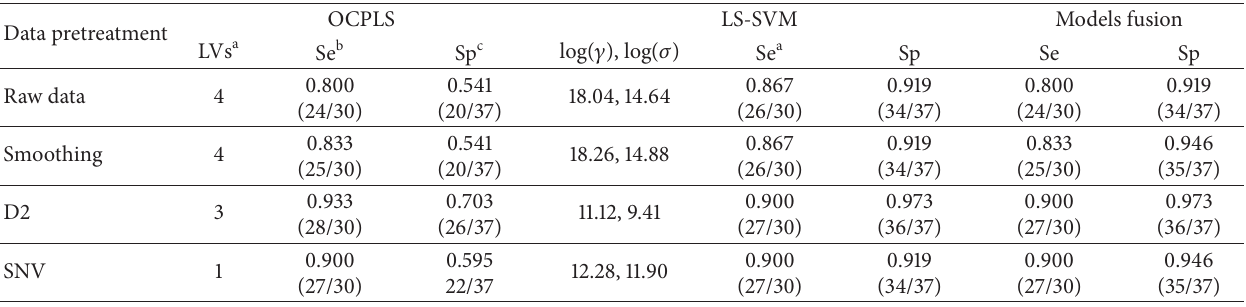
Table 3: Model parameters and prediction results of LS-SVM and OCPLS.